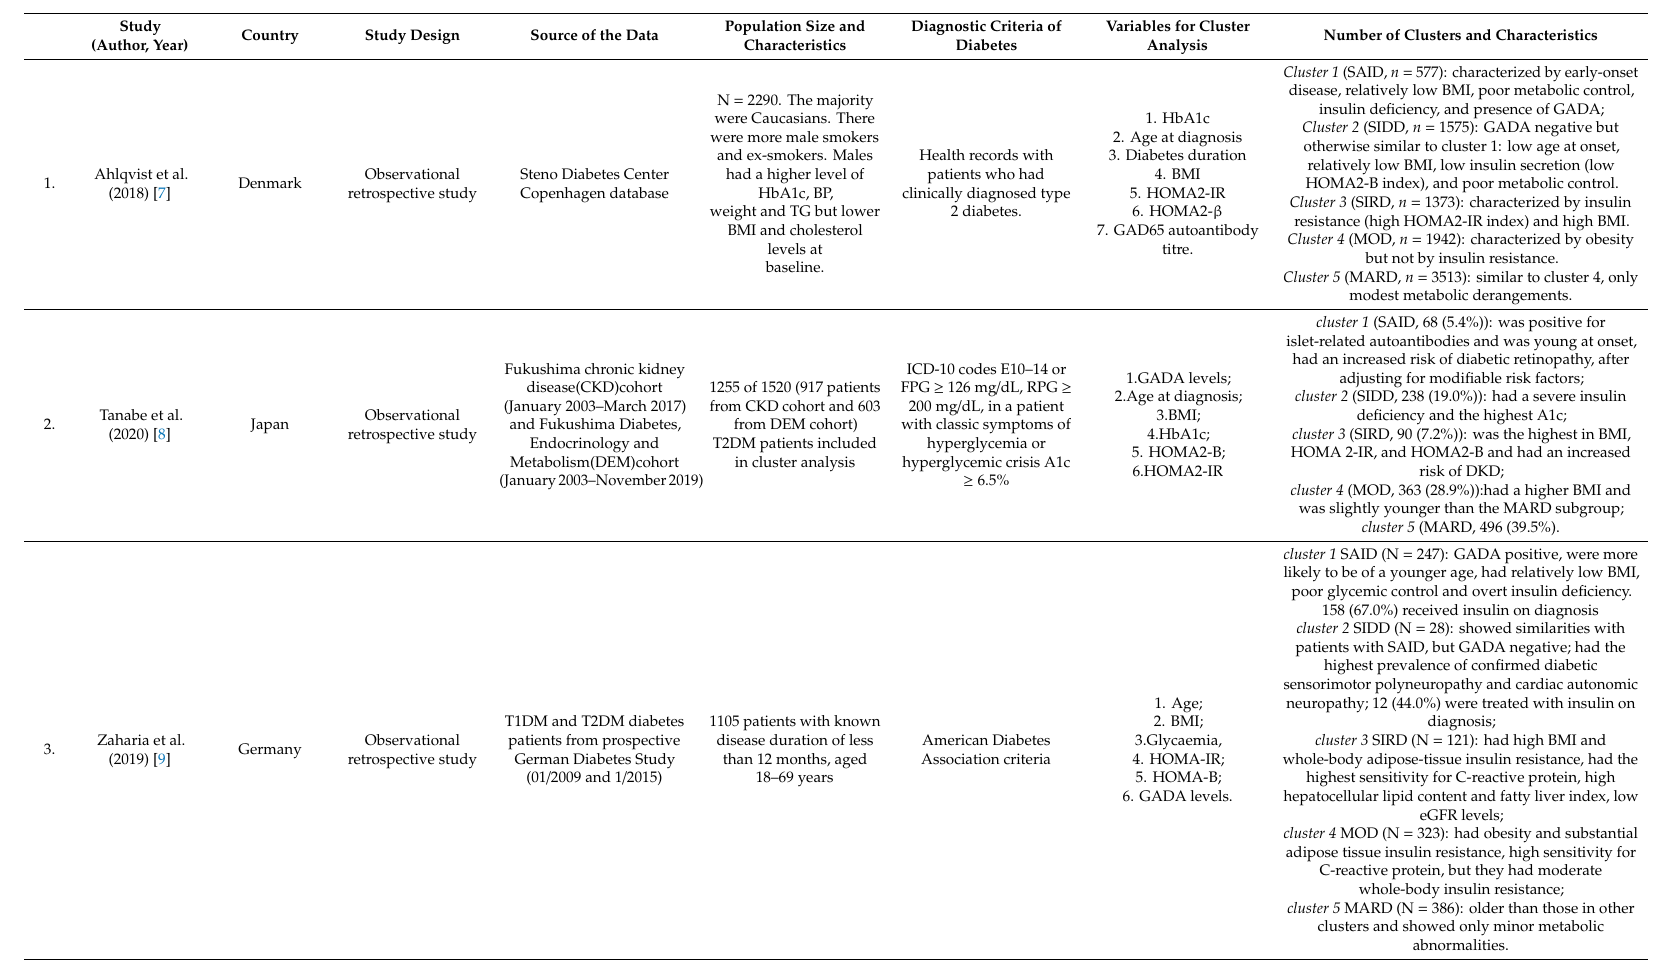
Table A1. Characteristics of included